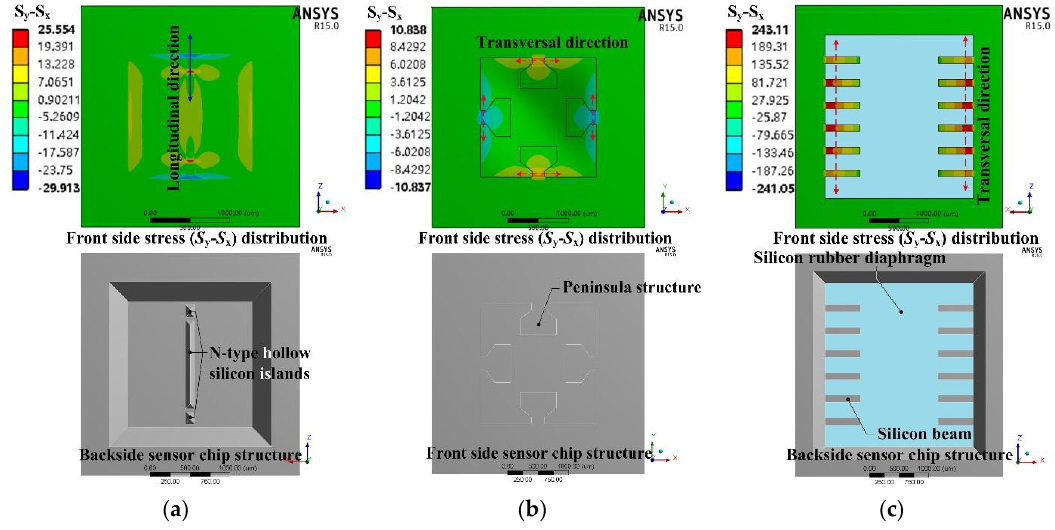
Figure 2. Diaphragm structure had either maximum bending stiffness along the transversal direction or minmum bending stiffness along the longitudinal direction: ( a ) Kinnell’s structure [21]; ( b ) Huang’s structure [22]; ( c ) Seo’s structure [33].